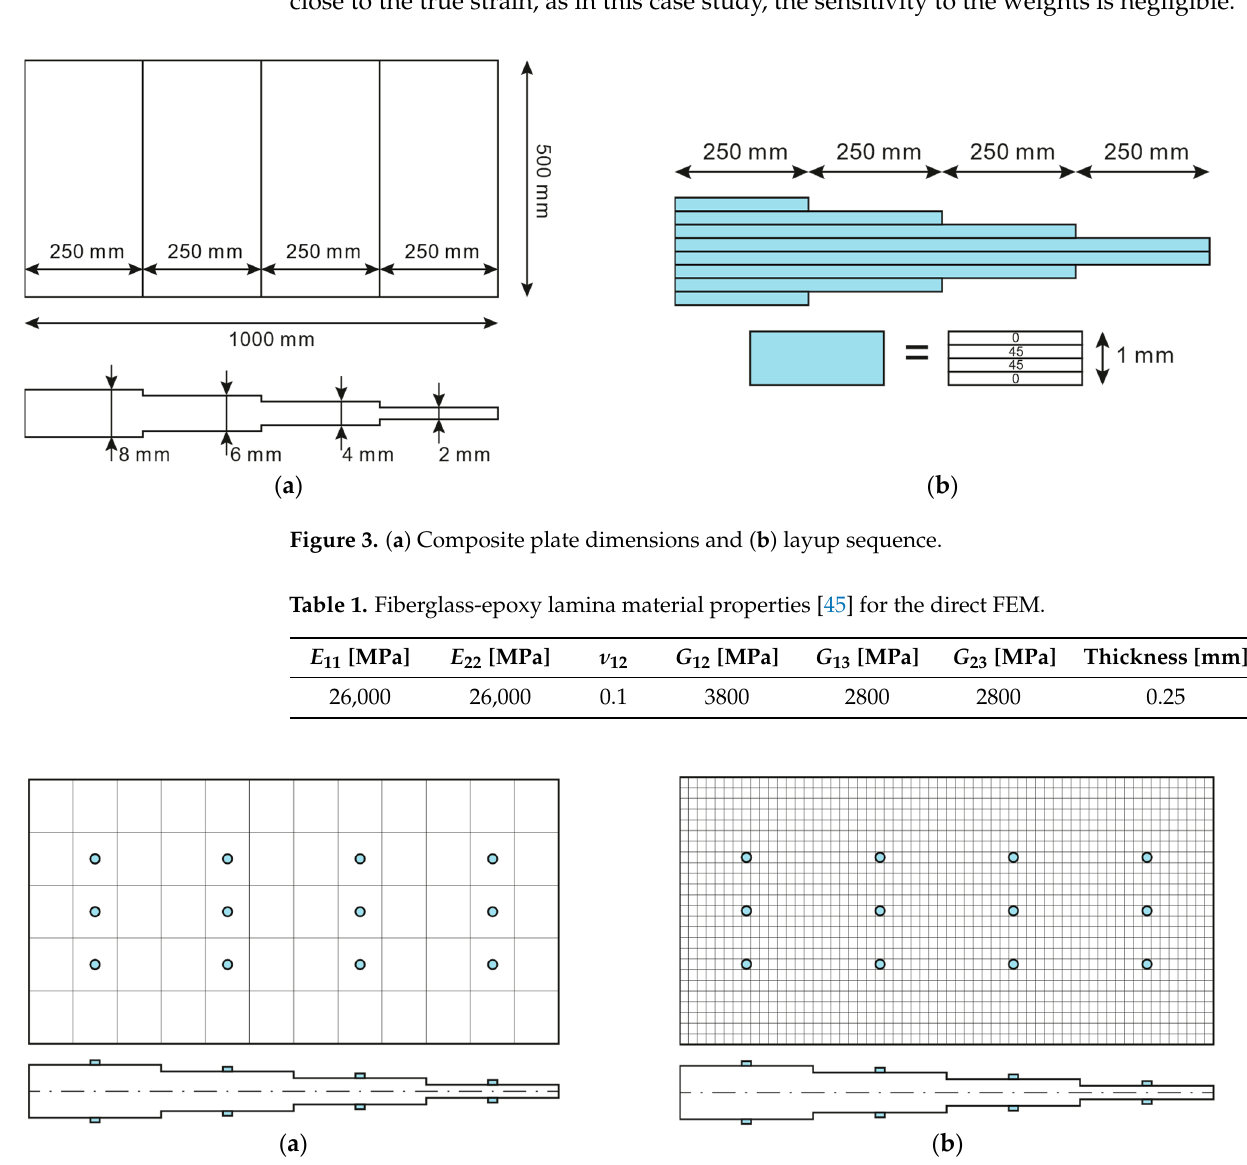
Figure 4. ( a ) iFEM mesh and ( b ) direct FEM mesh: Triaxial strain sensors are placed on both the bottom and top sides at each blue-filled circle. bottom and top sides at each blue-filled